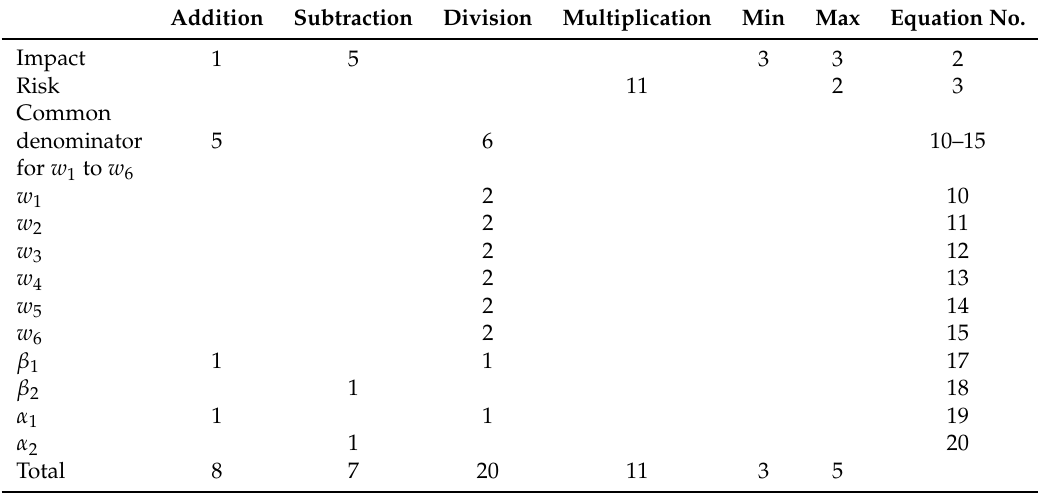
Table 12. Arithmetic operations of proposed